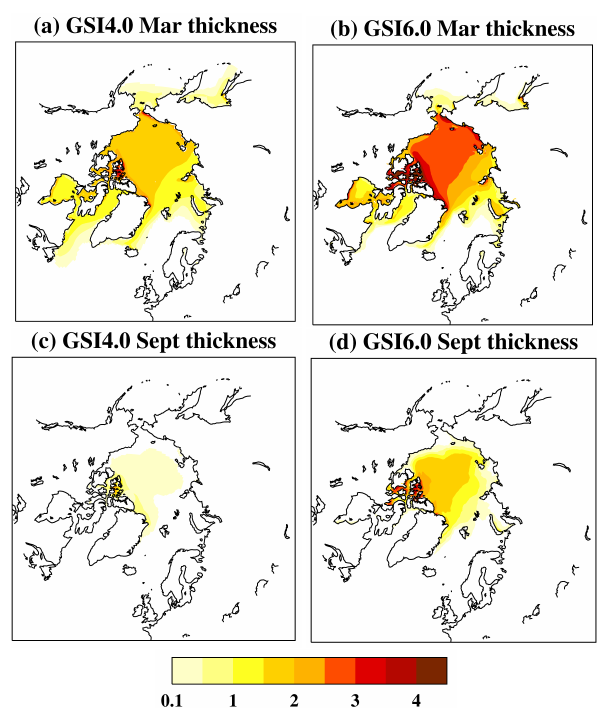
Figure 1. March and September 50-year mean Arctic sea ice thick- ness (m) in GSI4.0 and